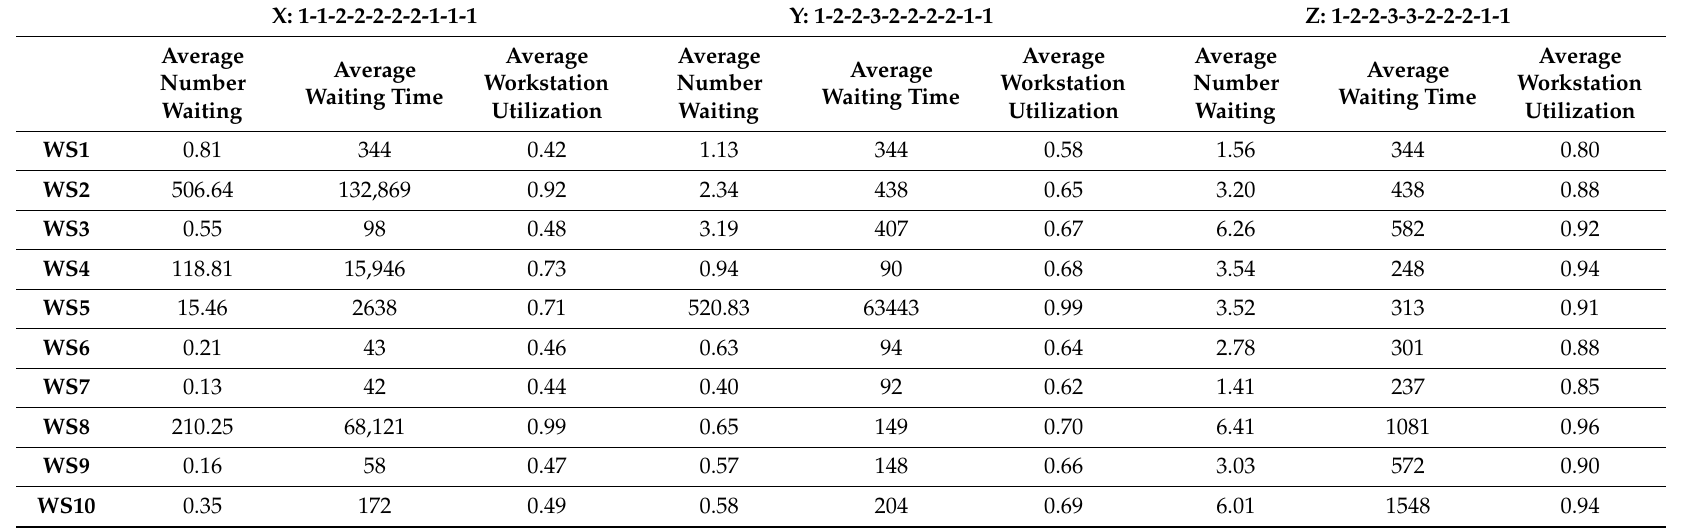
Table 3. Results of some runs according to different machine